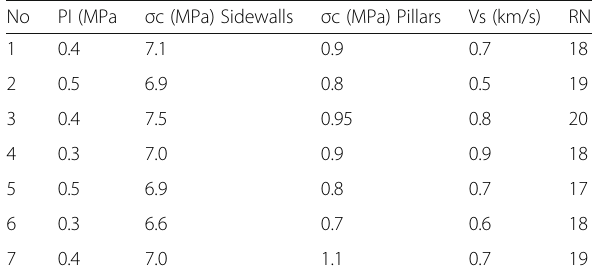
Table 1 The geotechnical properties of the intact rock samples